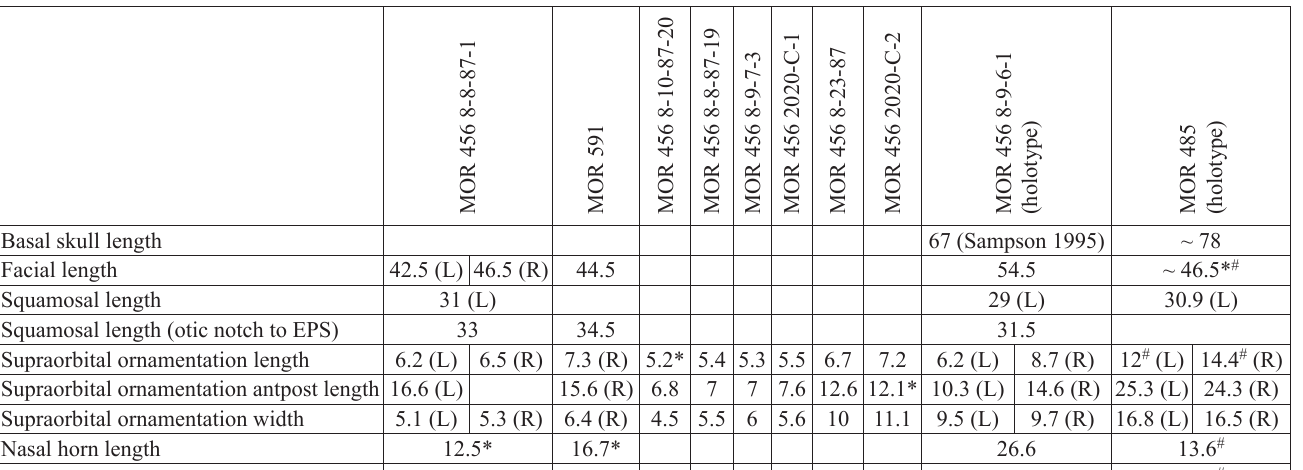
Table 1. Select measurements of MOR 456 8-8-87-1 and MOR 591 compared with the holotypes of Einiosaurus procurvicornis (MOR 456 8-9- 6-1) and Achelousaurus horneri (MOR 485) and Einiosaurus procurvicornis supraorbitals from the TM-046 bonebed. Facial length measured from anteriormost point of the nasal to the posterior margin of the orbit. Squamosal length is measured from the anteriormost process to the EPS. Supraorbital ornamentation width measured from lateral margin to medialmost extent of ornamentation. Nasal horn length measured from dorsal margin of nares to dorsalmost preserved extend of horncore. Note, much of the rostrum of MOR 485 is reconstructed. Abbreviations: L, left; R, right; *, incomplete element; #, measured using ImageJ (Rueden et al. 2017).